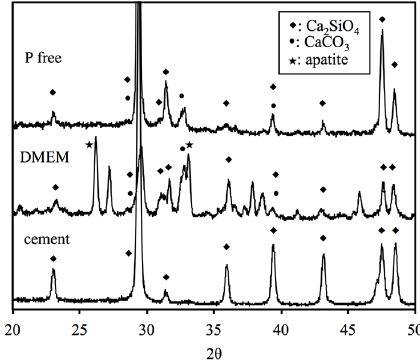
Figure 1. XRD patterns of CS before and after immersion in different DMEM for 24 h.